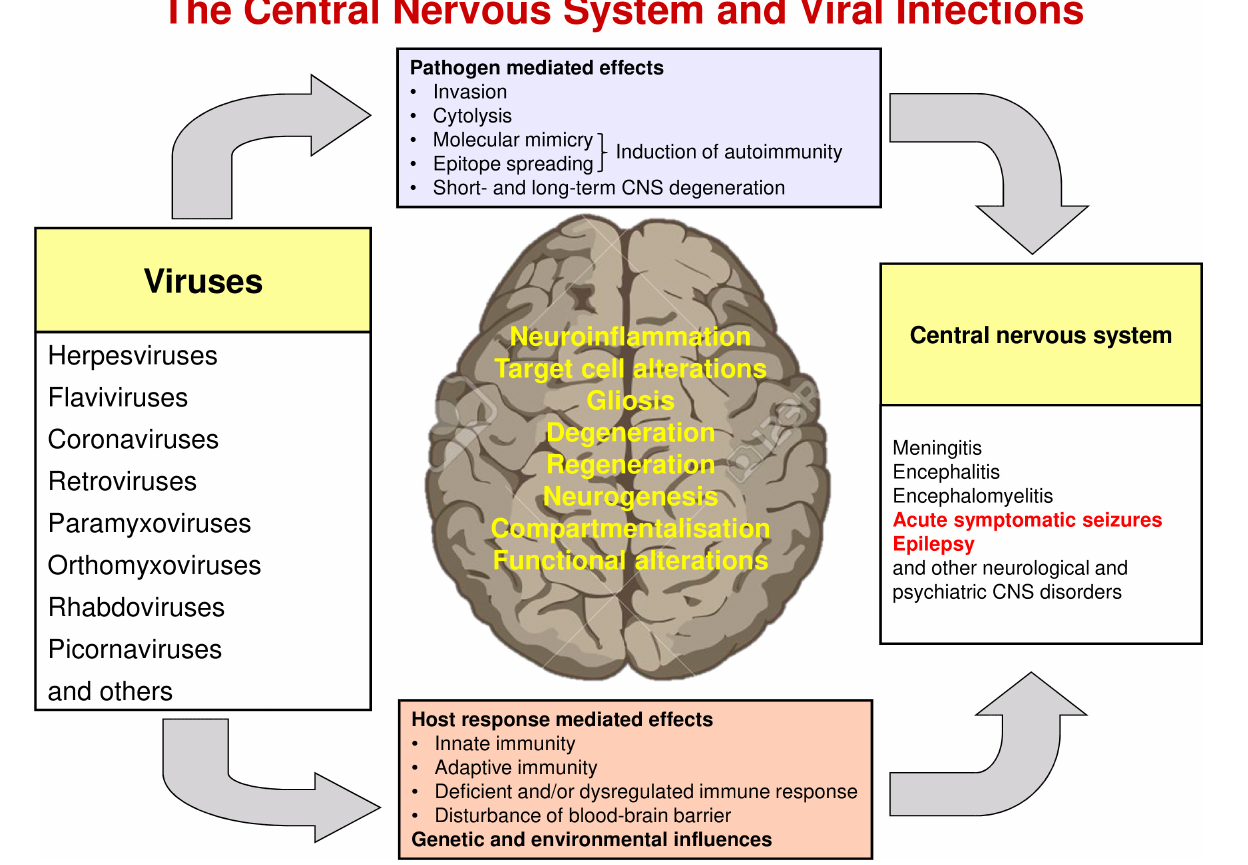
FIGURE 1 | Interactions of viruses and the central nervous system. Modified from Vezzani et al.